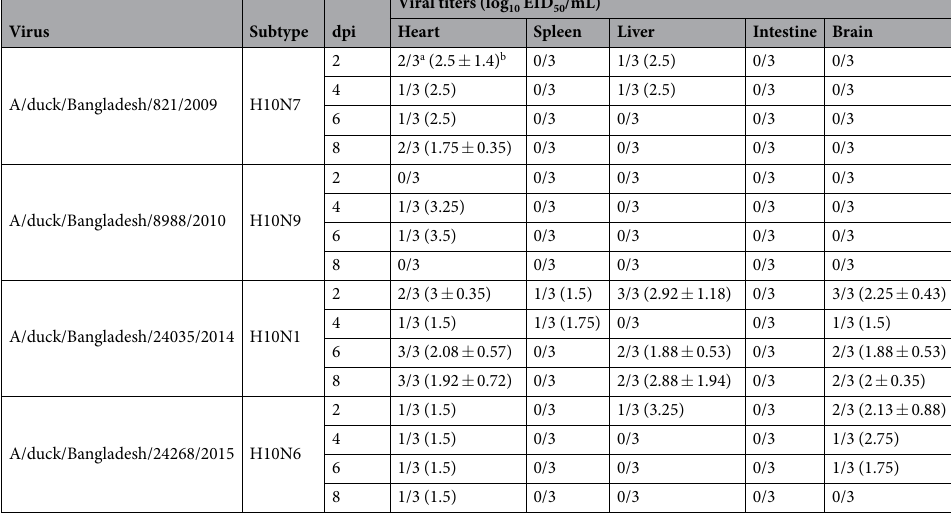
Table 3. Replication kinetics of H10 AIVs in extrapulmonary tissues in mice. a Infected mice were positive for virus detection /Total infected mice. b The titers are shown as the mean ±